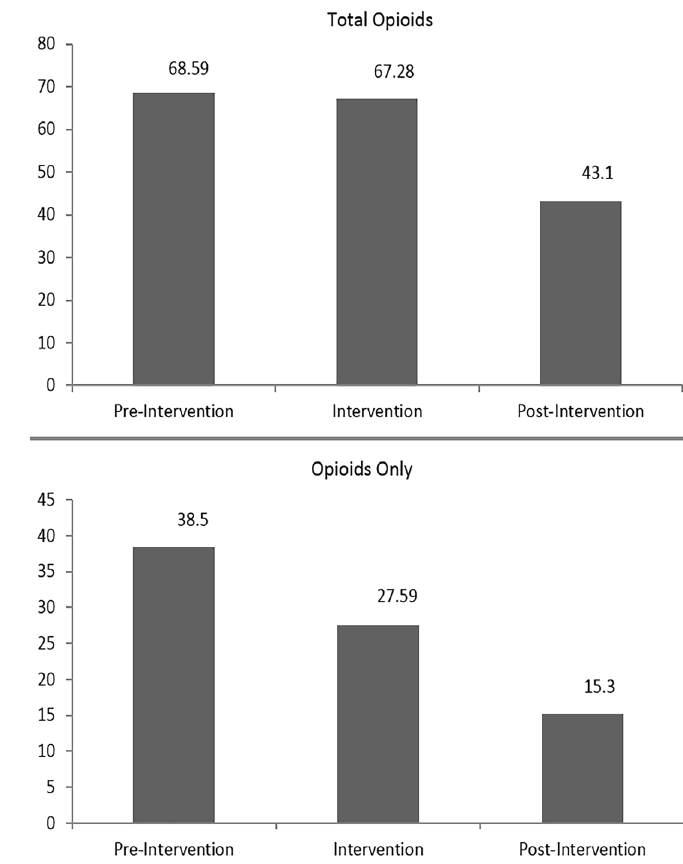
Figure 1. Percentages of opioid analgesic administration in the emergency department.